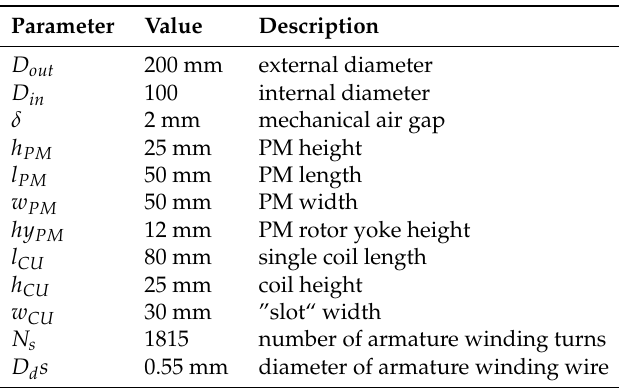
Table 1. Calculated dimensions of the designed